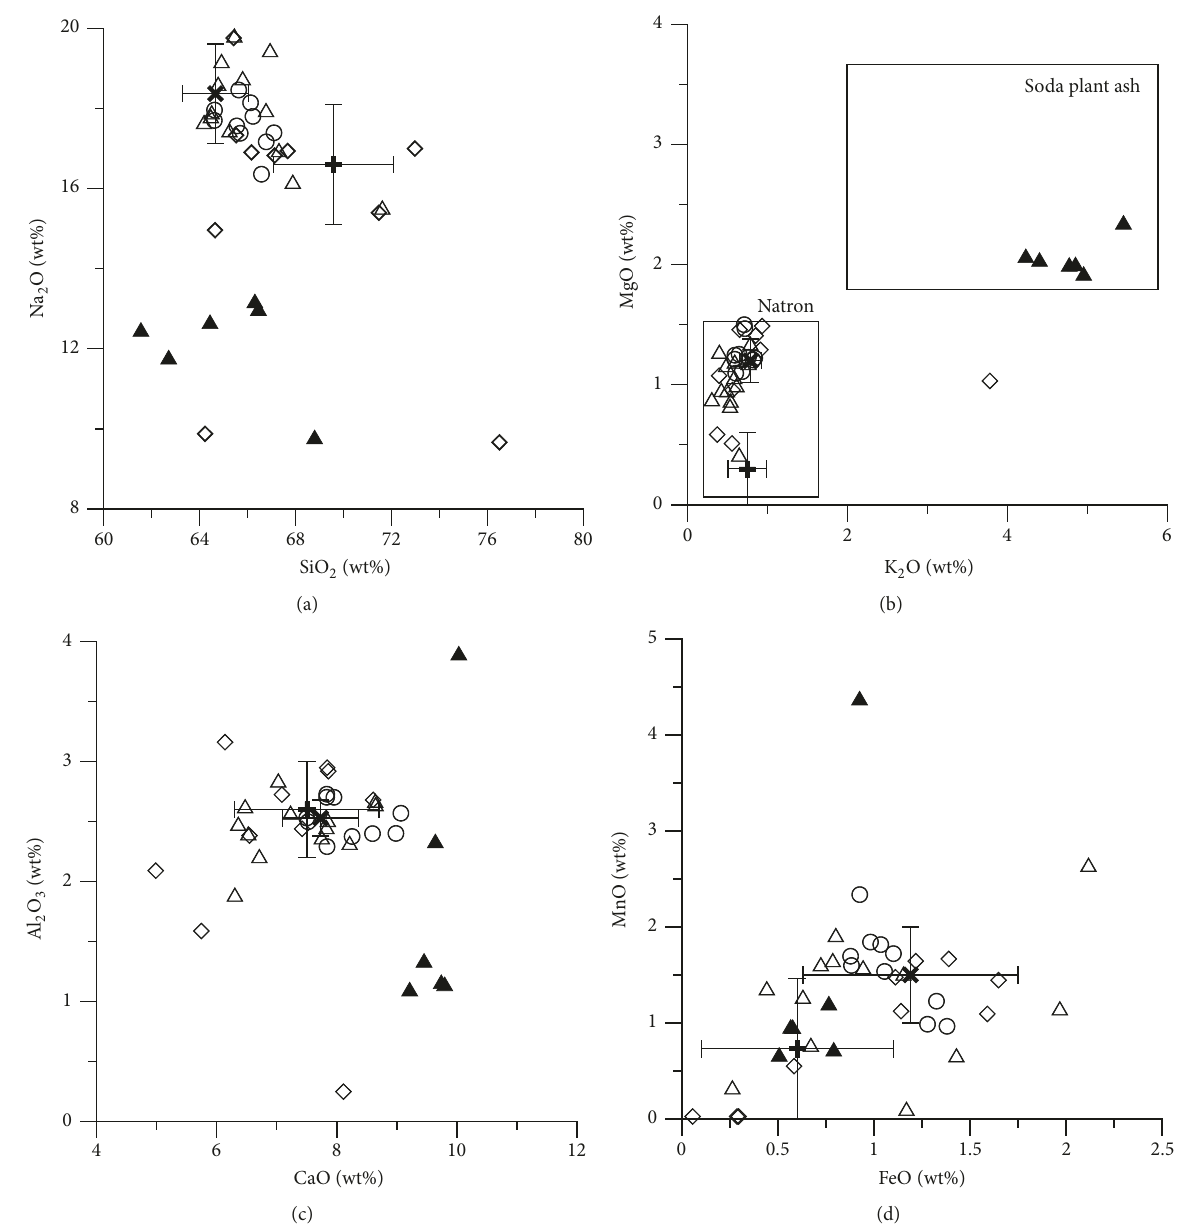
Figure 3: Na 2 O versus SiO 2 (a), MgO versus K 2 O (b), Al 2 O 3 versus CaO (c), and MnO versus FeO (d) contents of Greek glass samples, subdivided by provenance: Thessaloniki Agora ( ⬦ ), Maroneia ( I ), Thessaloniki, various sites ( 󳵻 : natron glass; 󳵳 : soda ash glass). Mean chemical compositions and standard deviations of main compositional natron groups, identified in literature and comparable with Greek samples, are also shown: “Roman” glass (bold plus sign), Group 2 (bold multiplication sign) [22, 35].